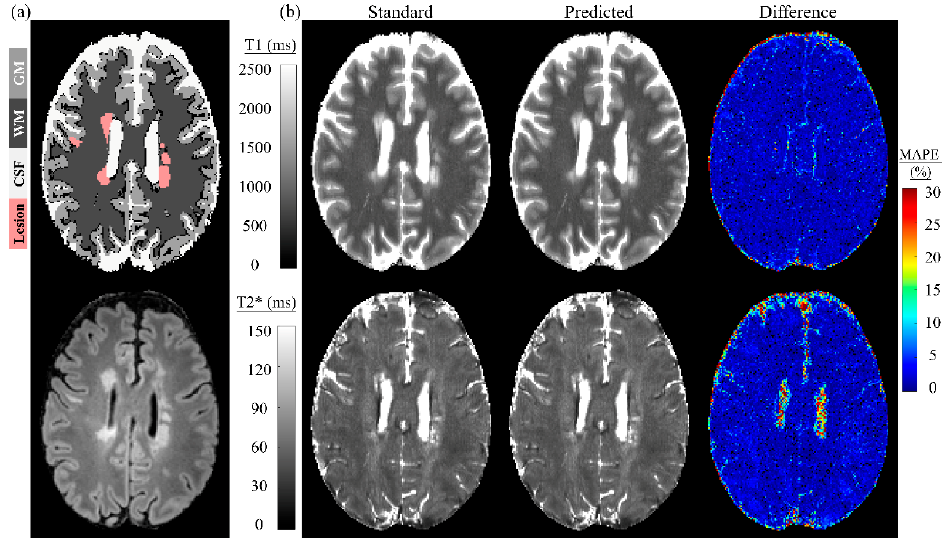
Figure 7. Magnetic resonance fingerprinting parametric maps of a single slice in an MS patient matched by the simulated dictionary (standard) and predicted by the proposed model. ( a ) Top is the tissue masks; bottom is the FLAIR. ( b ) Standard maps by dictionary matching, predicted maps by the proposed two-stage model, and difference maps between them.